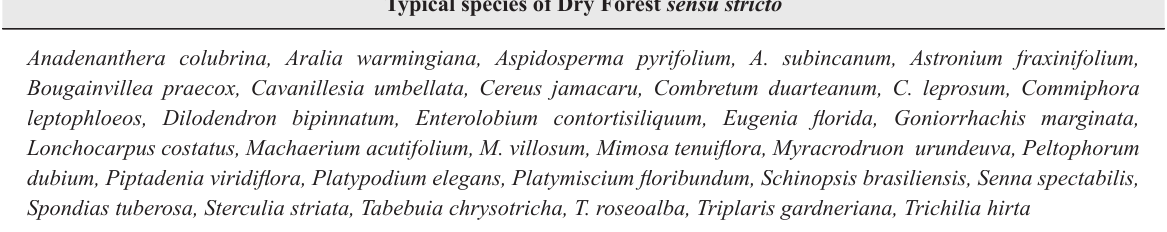
Determinant species of the groups formed by TWINSPAN analysis. The indicator species of specifi c groups are indicated in bold type. Species with only low occurrence between the areas of the groups do not appear in the